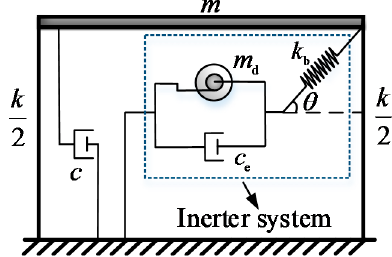
Figure 3. Layout of an SDOF system with a CBIS.